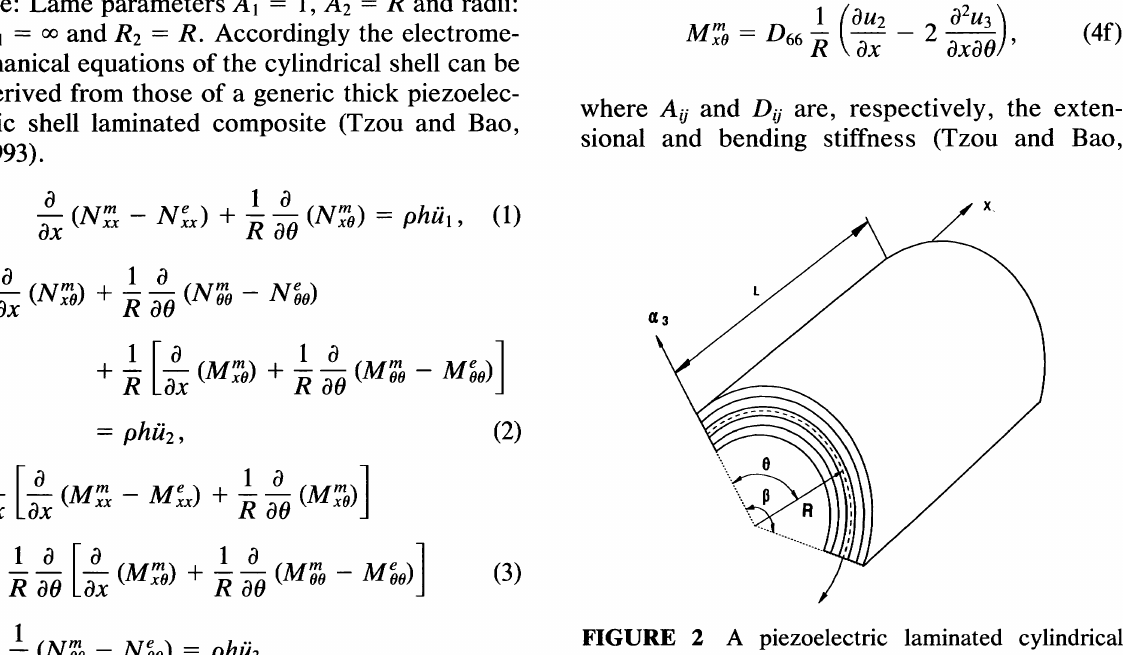
FIGURE 2 A piezoelectric laminated cylindrical shell